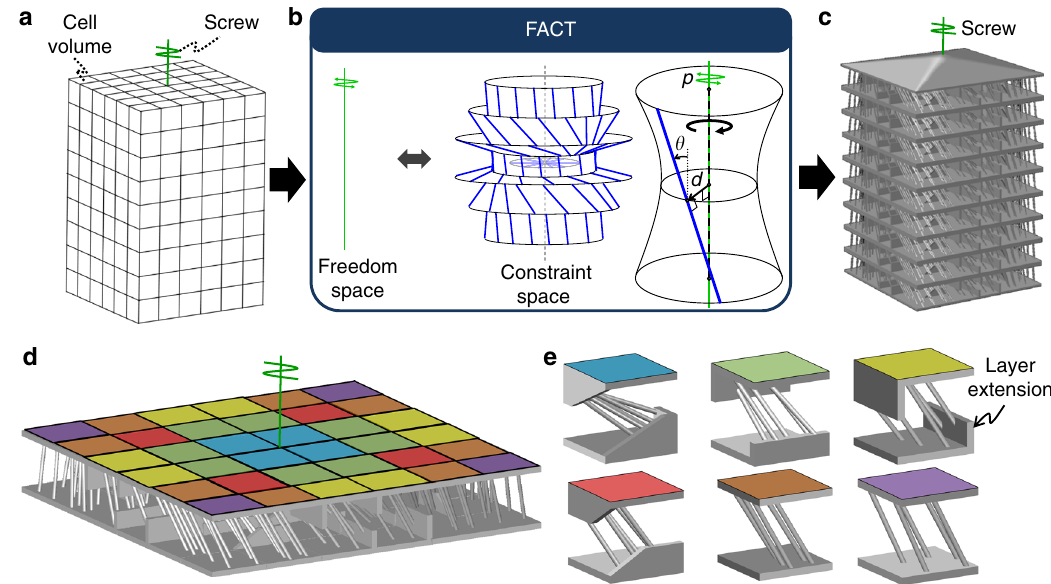
Fig. 2 Single degree-of-freedom (DOF) screw example. a The available volume is divided into individual cell volumes and the desired screw DOF is speci fi ed. b The screw DOF ’ s freedom space and its complementary constraint space shown with parameters that relate its geometry to the pitch, p , of the screw, c the resulting aperiodic directionally compliant metamaterial (DCM) design consisting of, d nine identical layers each made of, e six unique cell